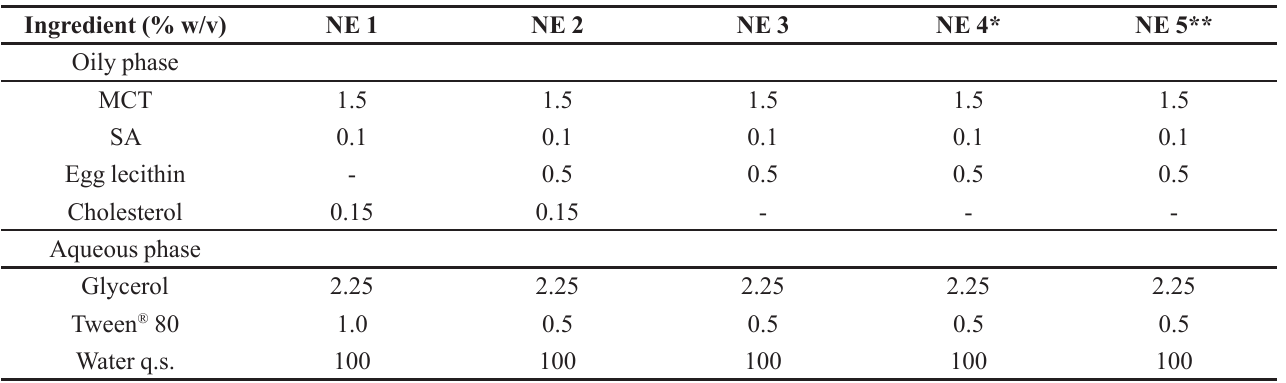
TABLE I – Composition of NE formulations containing different surfactant systems Ingredient (% w/v) Oily